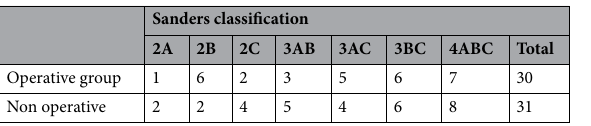
Table 1. Fractures classified as per Sanders types and mode of treatment.